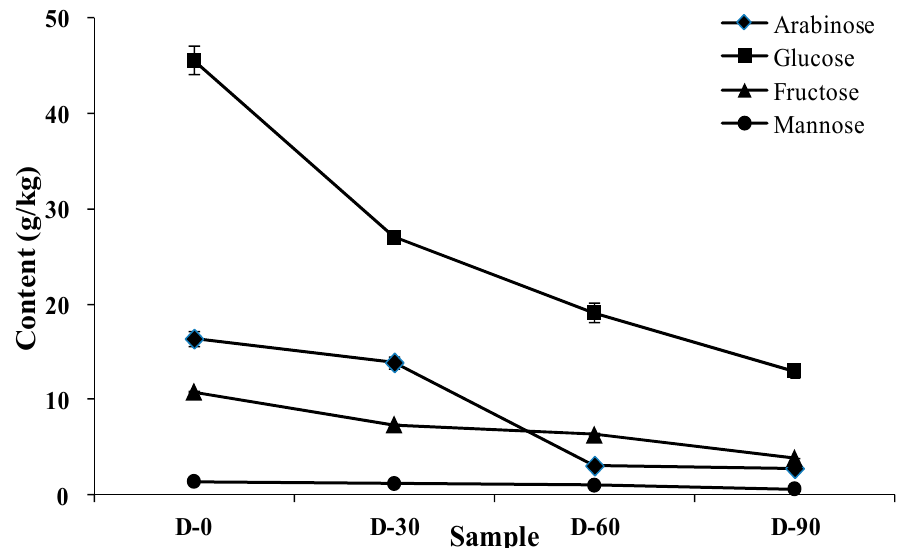
Figure 2. Effect of proofing on the soluble carbohydrate composition (g/kg) of CS–HPMC gluten-free dough.